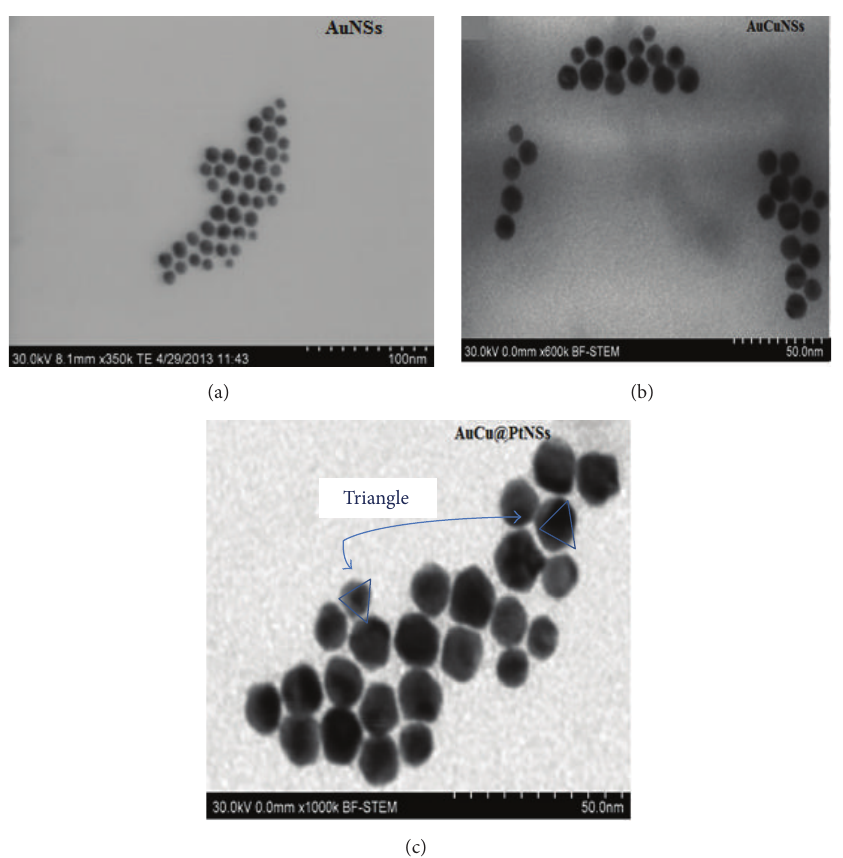
Figure 5: HRSEM for Au (a), AuCu (b), and AuCu@Pt (c)